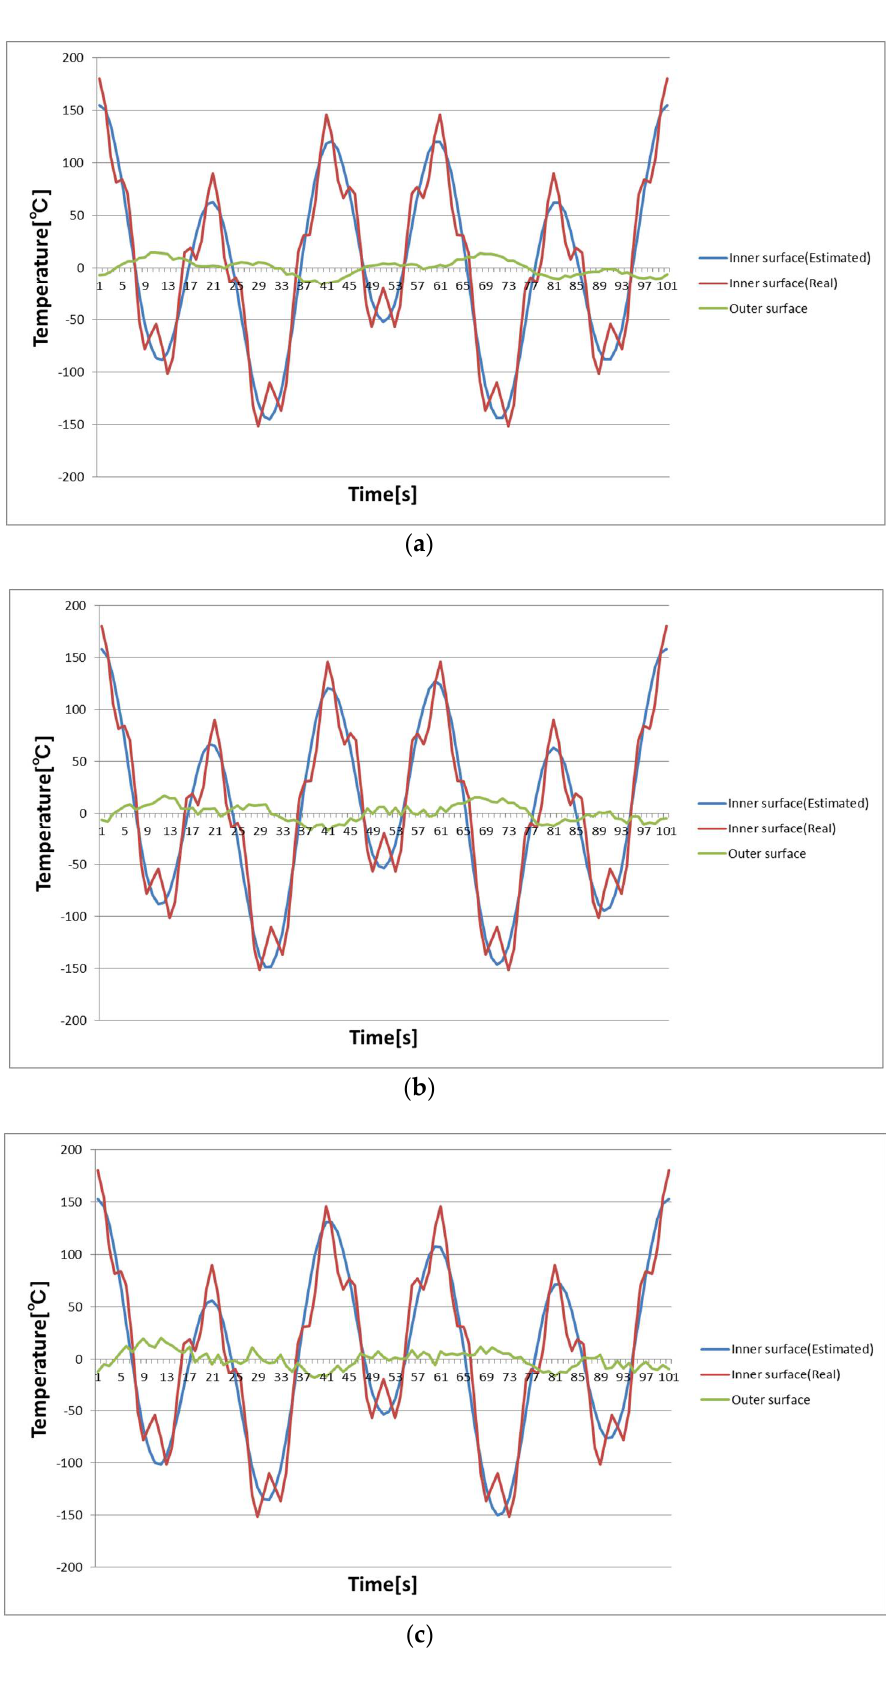
Figure 2. Estimated temperature variation on inner surface with regulation. ( a ) Observation noise of 2 °C; ( b ) Observation noise of 2 °C; ( c ) Observation noise of 8